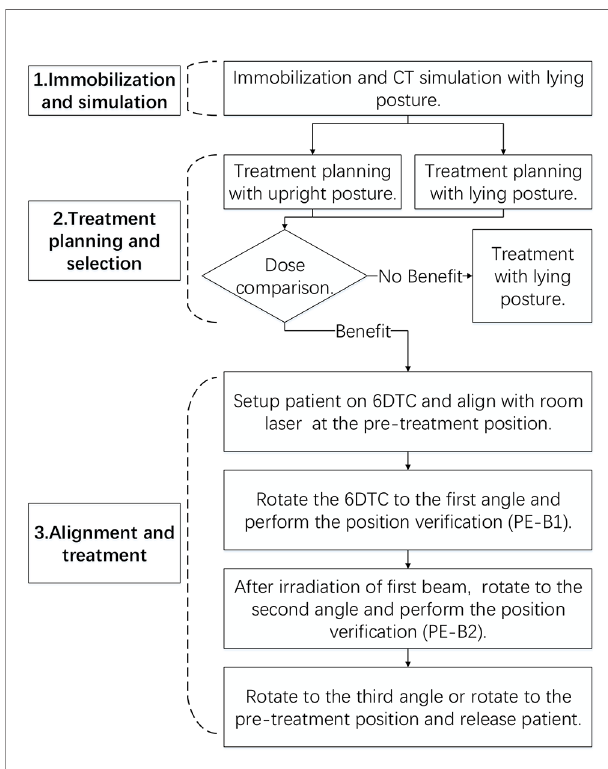
FIGURE 1 | The clinical treatment work fl ow for this clinical